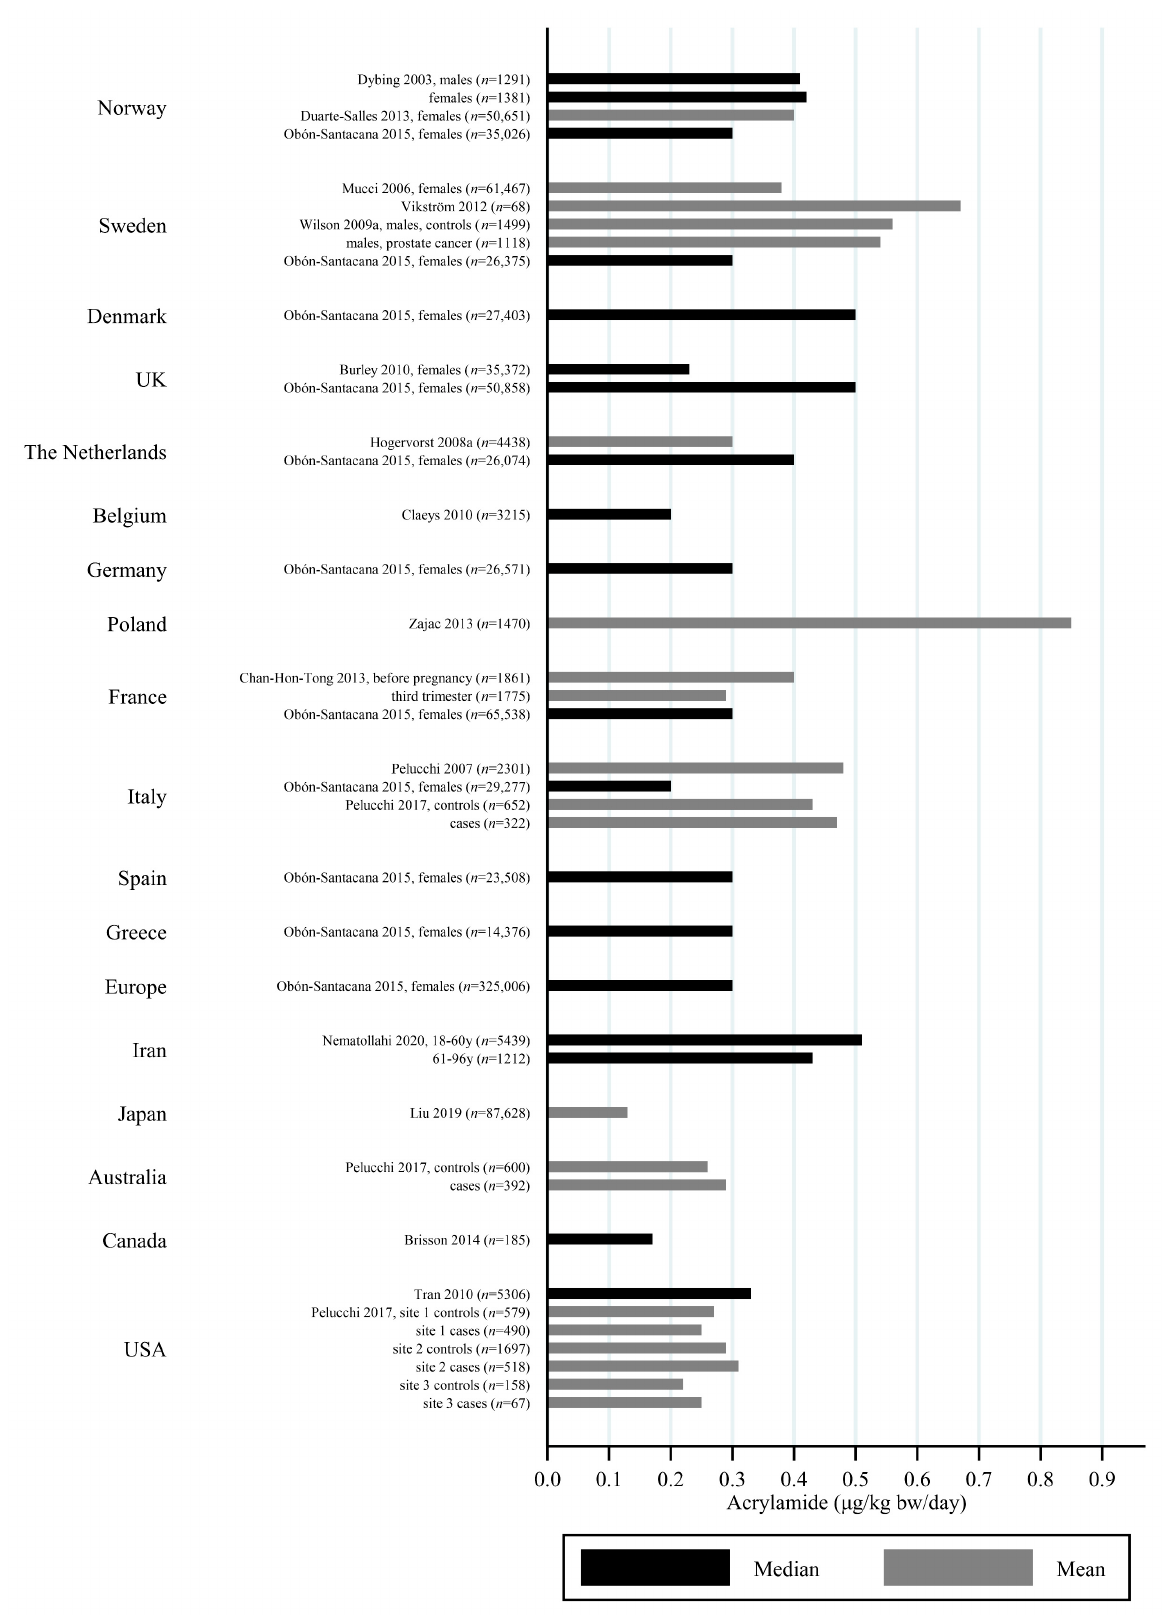
Figure 3. Median/mean estimated daily acrylamide intake per kg body weight ( µ g/kg bw/day), based on dietary questionnaire or both dietary questionnaire and dietary recall, by